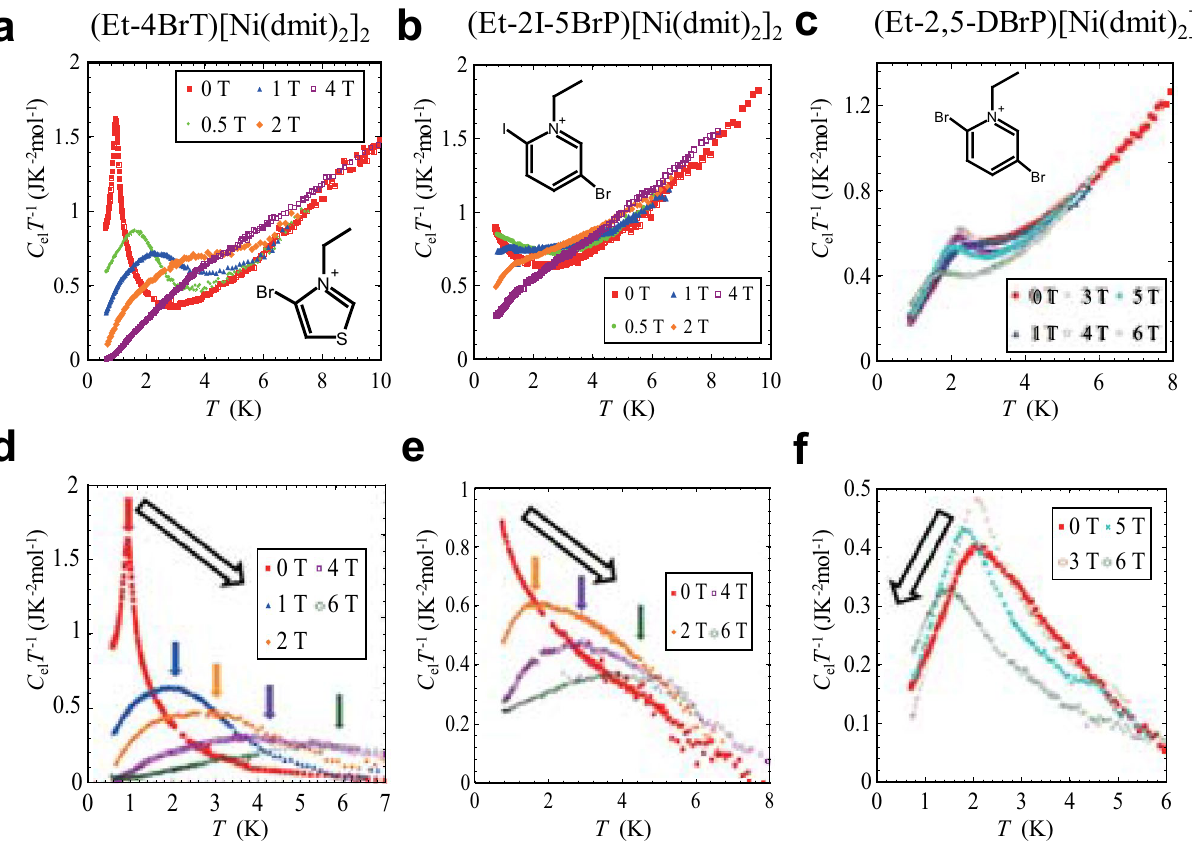
Figure 2. The temperature and the magnetic field dependences of the heat capacities of the series of bi-layer compounds. Temperature dependences of heat capacity of three bi-layer compounds of ( a ) (Et-4BrT) [Ni(dmit) 2 ] 2 , ( b ) (Et-2I-5BrP)[Ni(dmit) 2 ] 2 , and ( c ) (Et-2,5-DBrP)[Ni(dmit) 2 ] 2 . The magnetic heat capacities are shown in the same plot. The electronic contributions of the specific heat obtained by subtracting the lattice contributions for ( d ) (Et-4BrT)[Ni(dmit) 2 ] 2 , ( e (Et-2I-5BrP)[Ni(dmit) 2 ] 2 , and ( f ) (Et-2,5-DBrP)[Ni(dmit) 2 ] 2 are also shown. The colored arrows show the peak position of the magnetic heat capacity and the black arrows show the tendency of the peak shift with the increase of the magnetic field. The tendency in (Et-4BrT)[Ni(dmit) 2 ] 2 and (Et-2I-5BrP)[Ni(dmit) 2 ] 2 demonstrates that the ferromagnetic features